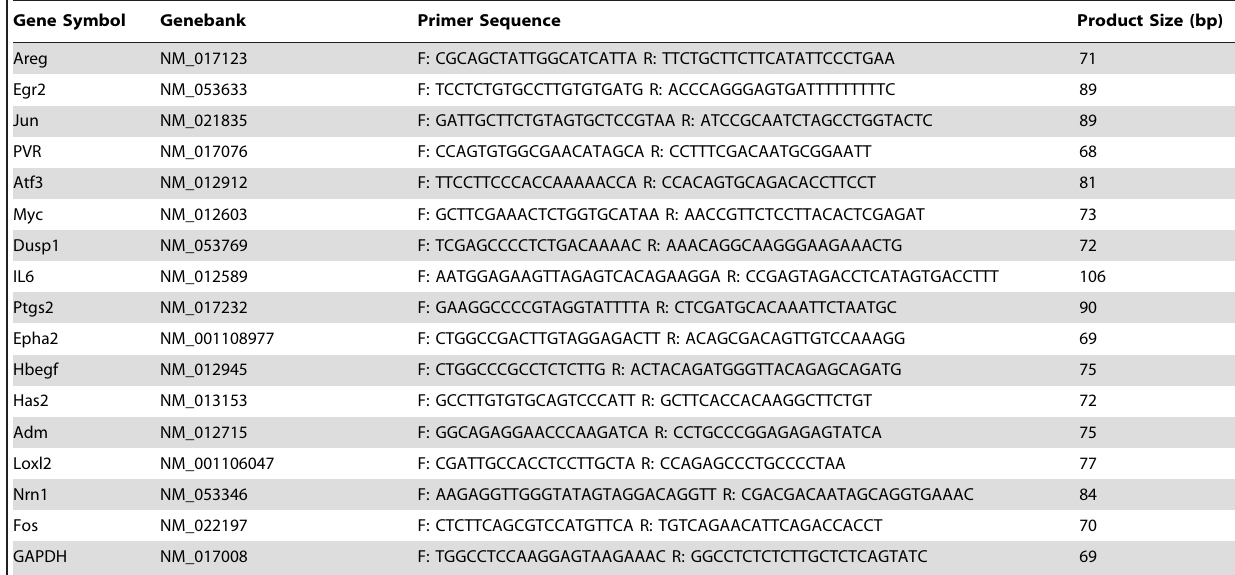
Table 5. Primers Used for qPCR.